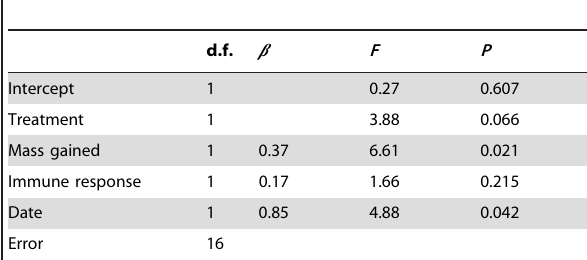
Table 2. Restricted Maximum Likelihood Estimation General Linear Mixed Model (REML-GLMM) showing the effect of treatment on concentration of malondialdehyde (MDA) as indicator of damage caused by oxidative stress, controlling for nest (random), date, mass gained and immune response to phytohaemagglutin.